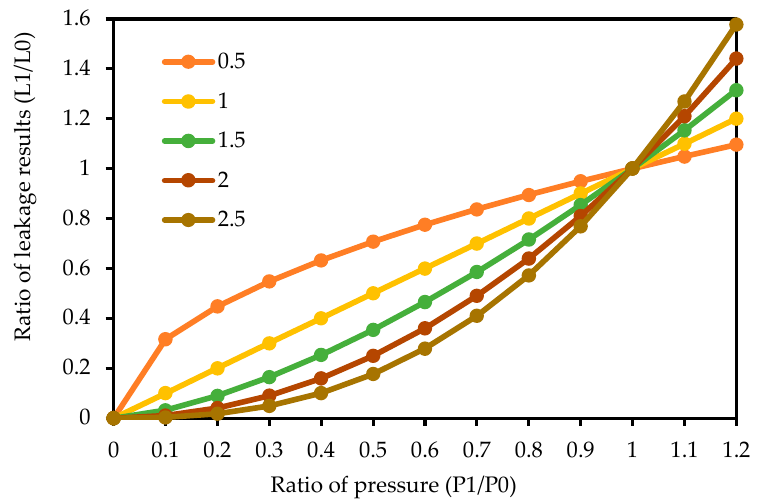
Figure 1. The general relationship between pressure and leakage rate, based on the FAVAD equation for different values of N 1 .